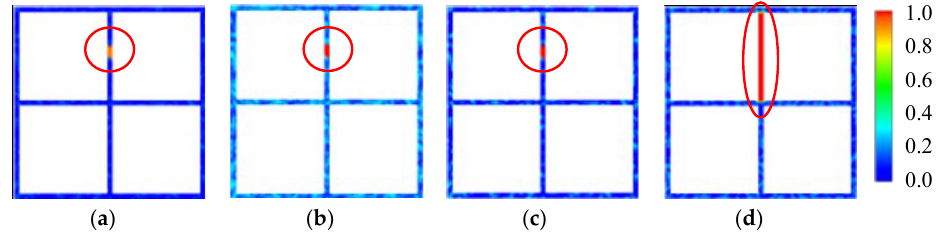
Figure 10. The imaging results of 2 2  block with different corrosion degrees. ( a ) Case 1; ( b ) Case